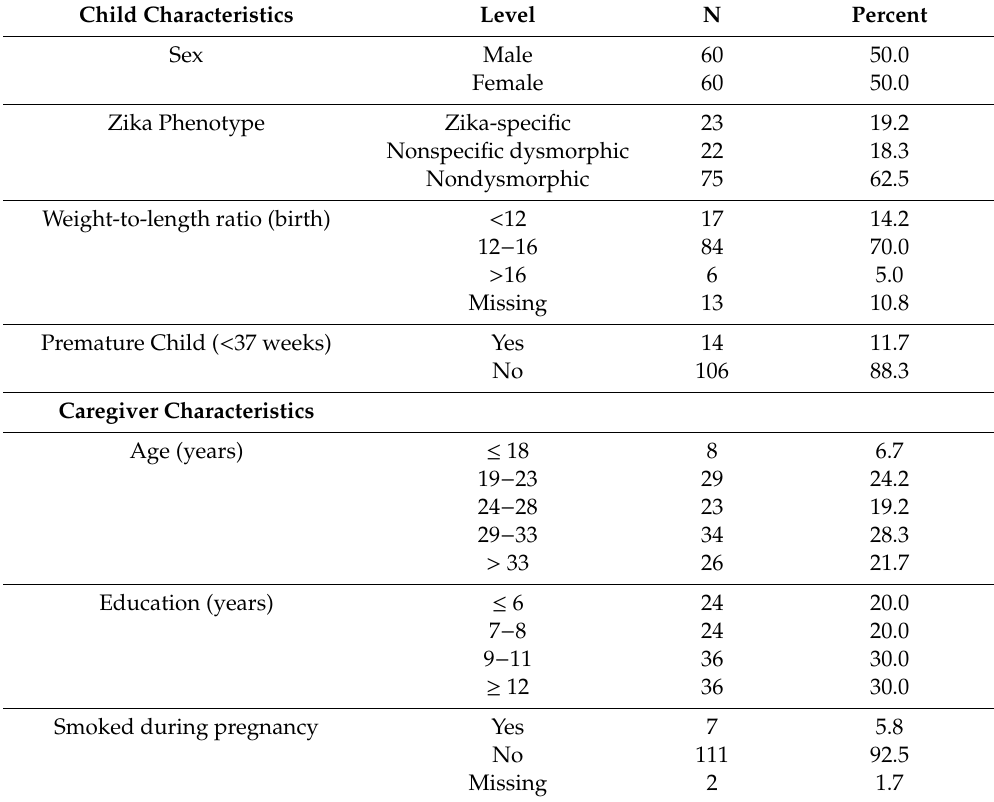
Table 1. Demographic characteristics for the 120 children and their caregivers in the 2017 Zika Outcomes and Development in Infants and Children (ZODIAC)